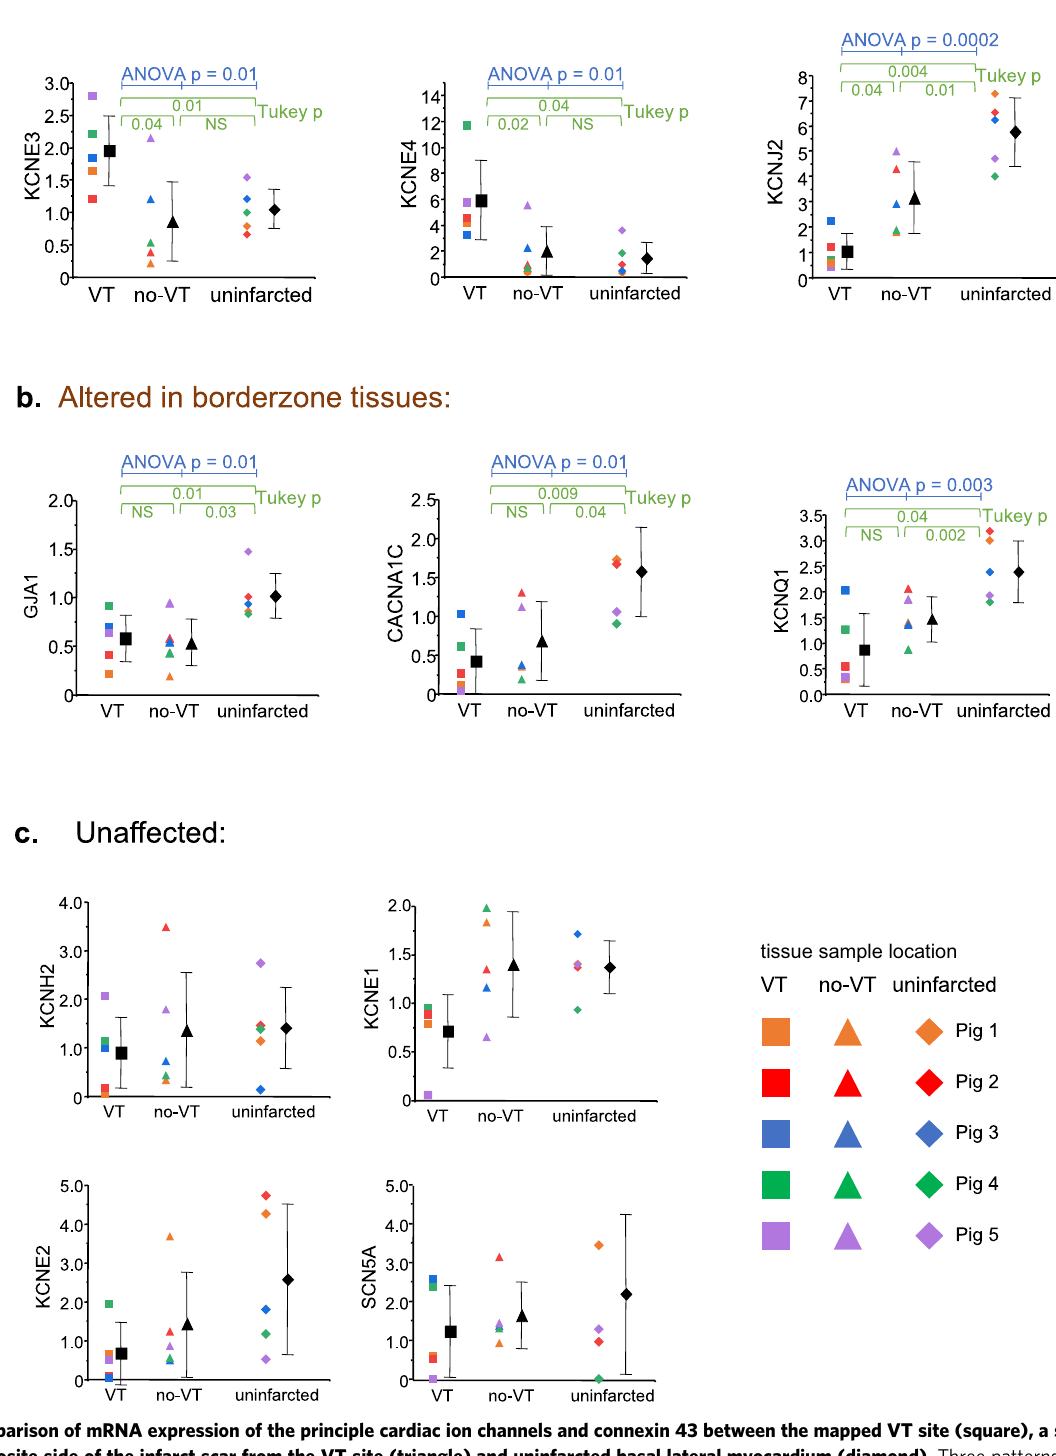
Fig. 2 Comparison of mRNA expression of the principle cardiac ion channels and connexin 43 between the mapped VT site (square), a site harvested on the opposite side of the infarct scar from the VT site (triangle) and uninfarcted basal lateral myocardium (diamond). Three patterns of expression emerged in the analysis. a Transcripts uniquely altered in the VT circuit. b Transcripts decreased generally in borderzone but not uniquely in VT circuits. c Transcripts that were not statistically different between the three tested sites. As noted in the text, for these experiments, n = 5 biologically independent animals. Mapped VT circuit sites are noted by square symbols, infarct scar tissue not involved in VT by triangle symbols, and uninfarcted myocardial sites by diamond symbols. Data are reported as mean ± standard deviation. Data analysis included the Shapiro – Wilk test for normality followed by one-way ANOVA with the post-hoc Tukey test to assess differences. Source data are provided as a Source Data fi